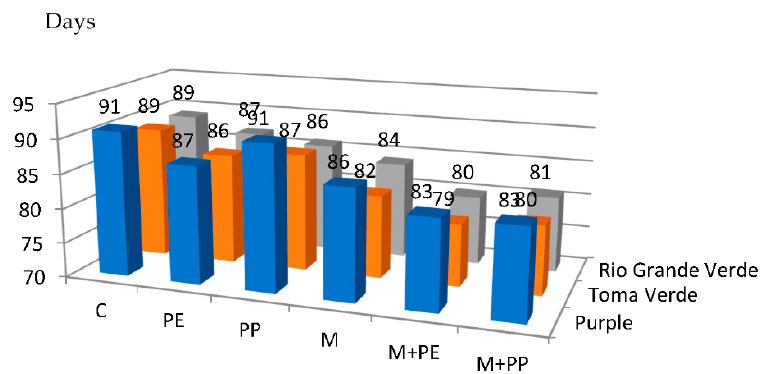
Figure 7. The effects of cultivar, plant covers and soil mulching on the number of days between transplanting seedlings to the first harvest of tomatillo fruit) (means of 2015, 2017–2018). Explanation: C—control; PE—perforated PE film with 100 openings per m 2 for covering field beds (PE); PP—non-woven PP fabric with surface density of 17 g m − 2 for covering field beds; M—black PE film with a thickness of 0.05 mm for mulching; M + PE—black PE film with a thickness of 0.05 mm for mulching + perforated PE film with 100 openings per m 2 for covering field bed; M + PP—black PE film with a thickness of 0.05 mm for mulching + non-woven PP fabric with surface density of 17 g m − 2 for covering field beds. Table 10. The effects of cultivar, plant covers and mulching on the total tomatillo fruit yield (kg · m − 2 ) (means of 2015,